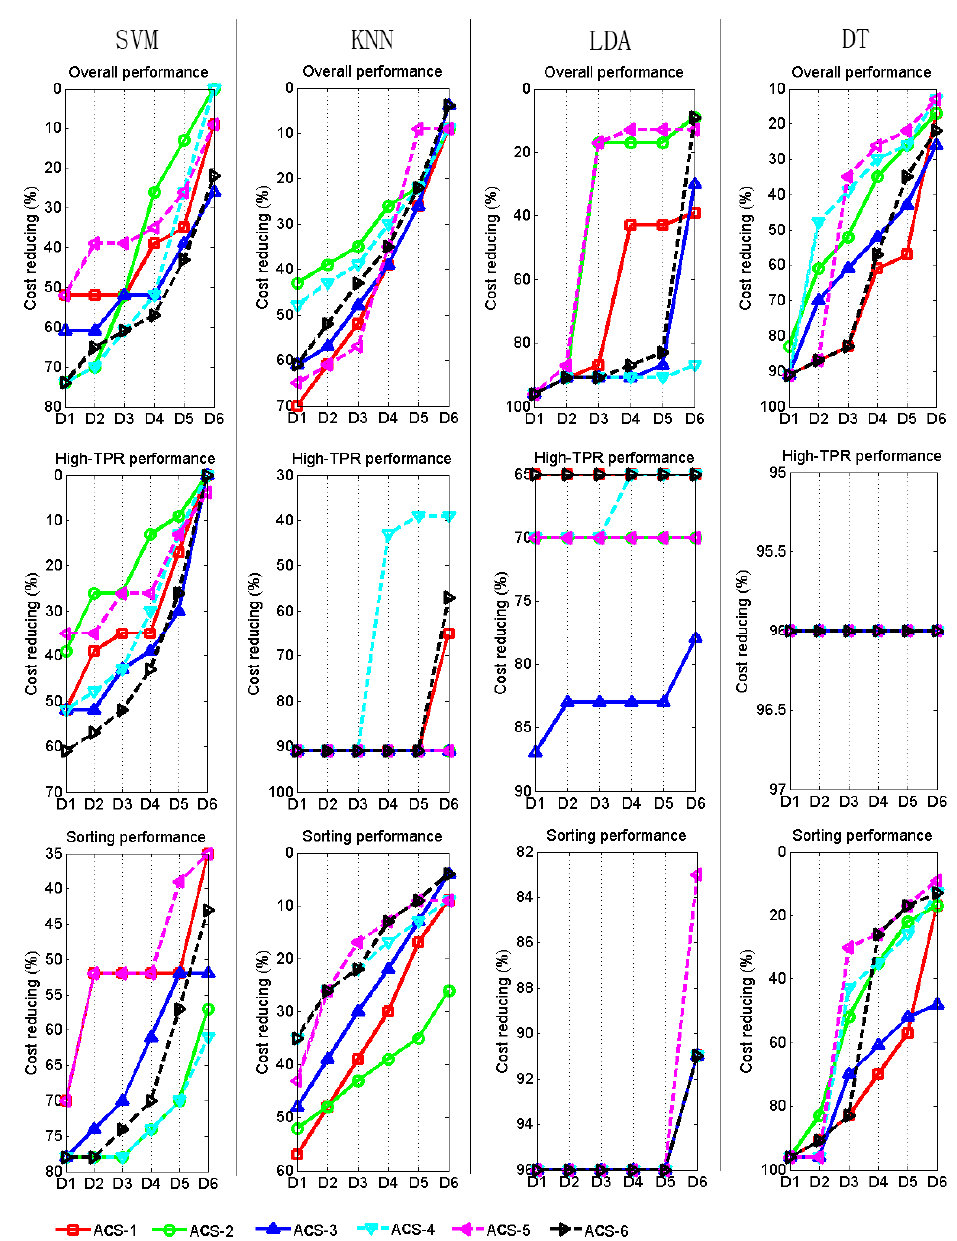
Figure 7. The cost reduction for achieving different destination performances with ACS methods coupled with SVM, KNN, LDA and DT classifier. Designated performances D1 to D6 stand for 90% to 100% of the baseline performance achieved by the classier using all training samples without AL.